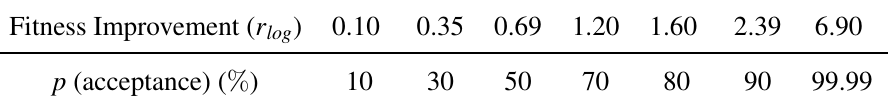
Table 3. Probability of acceptance depending on the fitness value